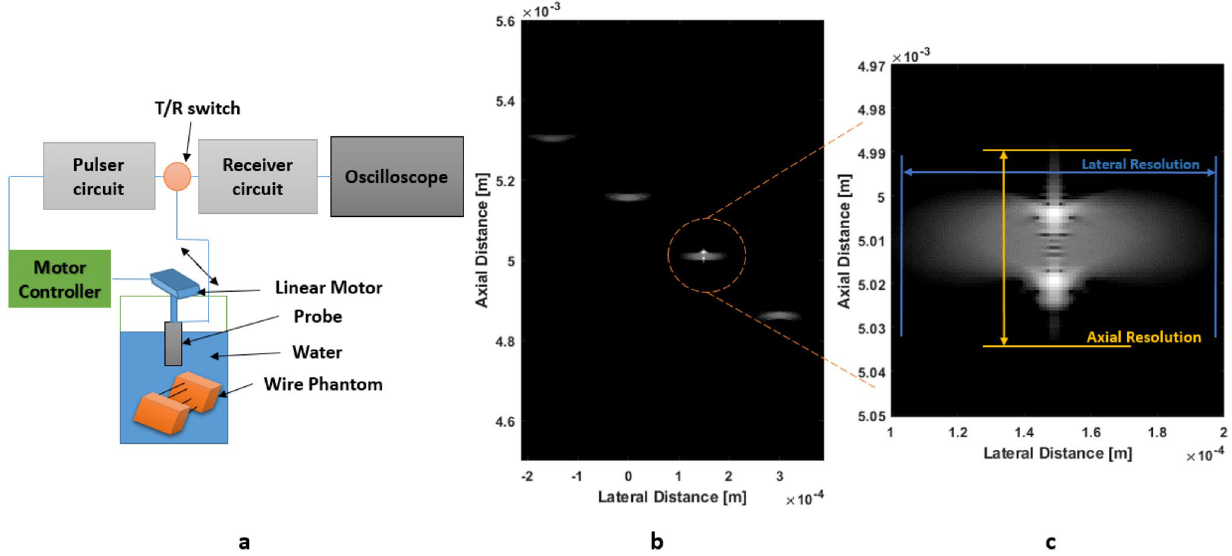
sions used for determining the resolutions are shown. This simula- tion was performed using Field